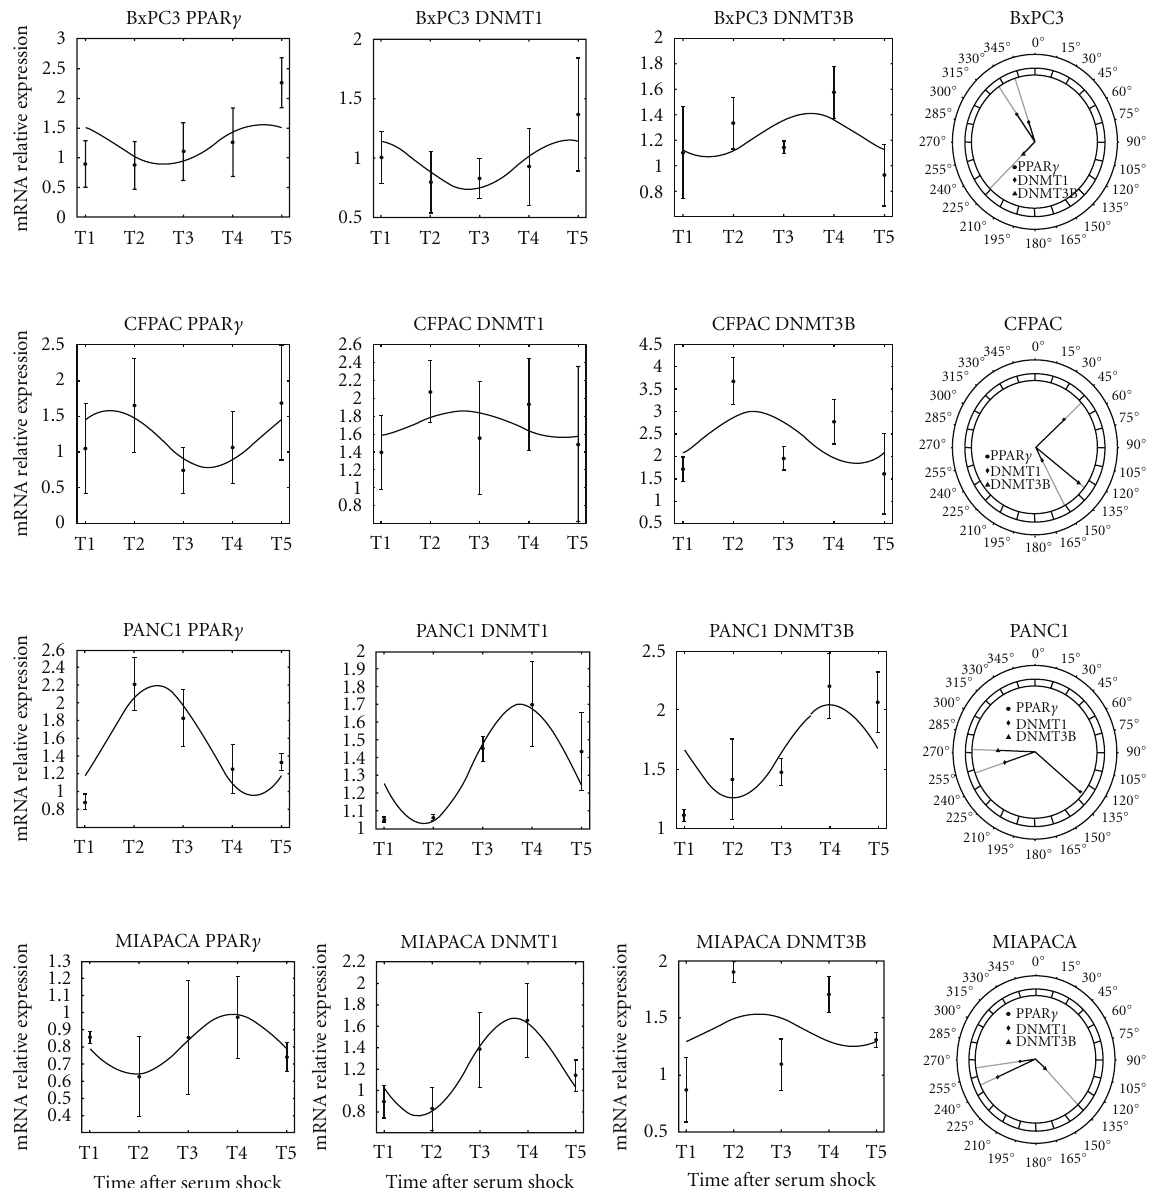
Figure 1: Chronograms displaying time qualified variations of PPARG , DNMT1 , and DNMT3B expression level in pancreatic cancer cell lines. Original units standardized to T0 and combined for analyses. Polarograms of cosinor analysis showing the acrophases for the expression values of PPARG , DNMT1 , and DNMT3B . Radial axis represents the time point (in degrees) after serum shock corresponding to the acme and vector length represents the amplitude of the